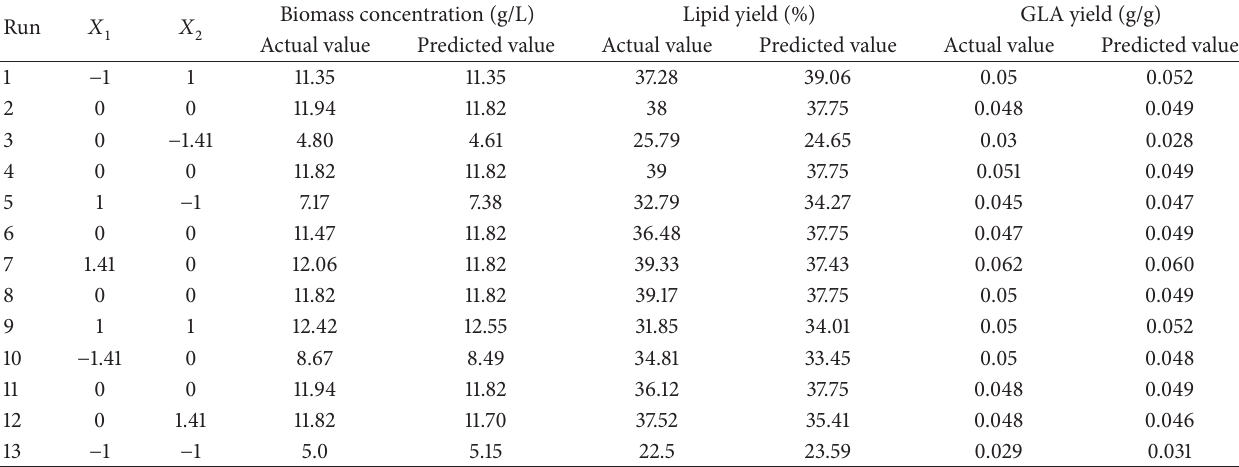
Table 3: Experimental design and test results of biomass concentration, lipid yield, and GLA yield produced by Cunninghamella bainieri 2A1 in the submerged bioreactor.